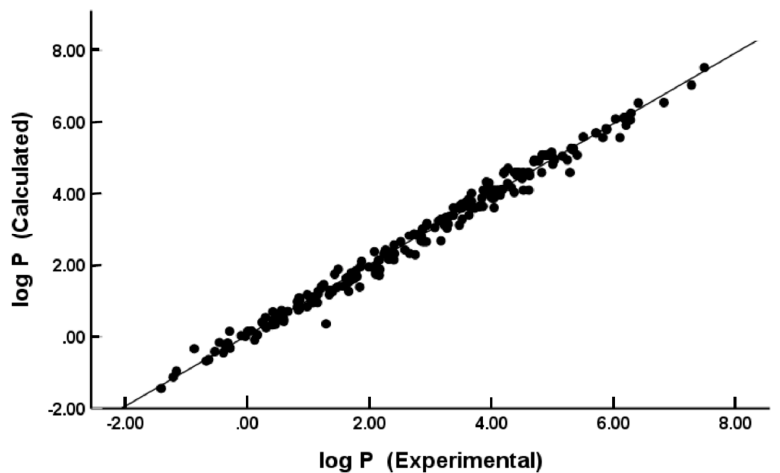
Figure 1. Comparison of observed log P PDMS-water data versus back-calculated values based on Equa- tion (11) for PDMS.